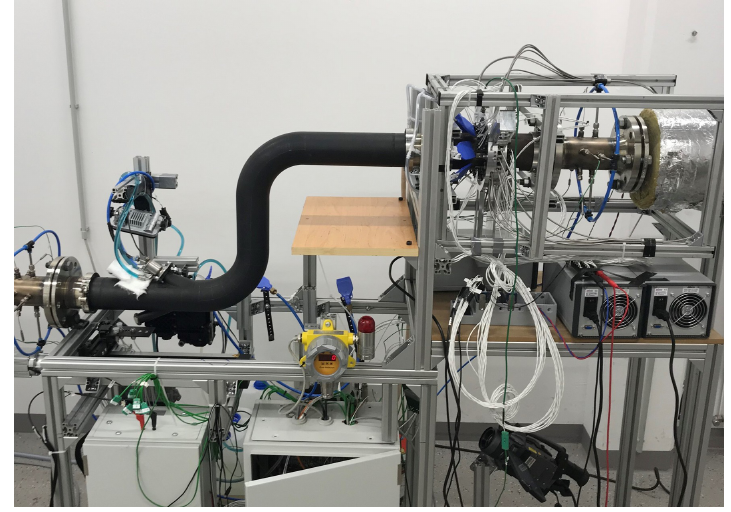
Figure 11. Experiment 2: UWS Injection into an S-shaped